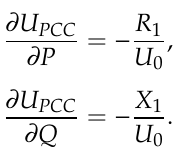
Figure 5. Outer-loop control strategy of SOP: ( a ) Active power regulation to DC voltage; ( b ) Reactive power regulation to AC voltage; ( c ) mixed regulation to AC voltage.